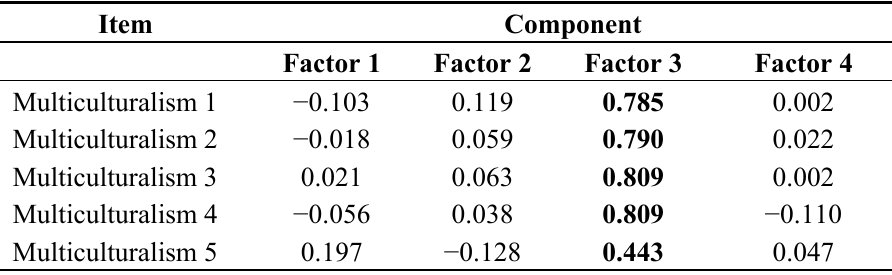
Table 1. Exploratory factor analysis: eigenvalues, percentage of explained variance by each factor and factor